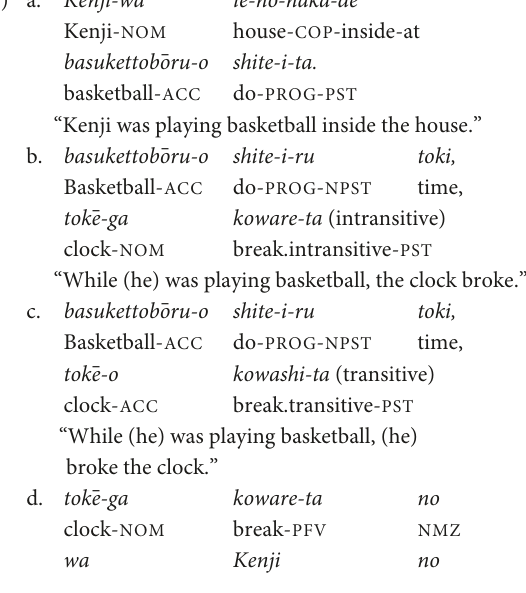
Figure 1 . The data were first transformed using a Box-Cox transformation. The transformed data were then fitted to a generalized linear mixed model using glmer() in the lme4 package for R (Bates et al., 2015) with the construction type as the fixed variable and participants and items as the random variables. The model was significantly different from the null model with the random variables only [ χ 2 (3) = 181.55, p < 0.001], revealing a main effect for construction